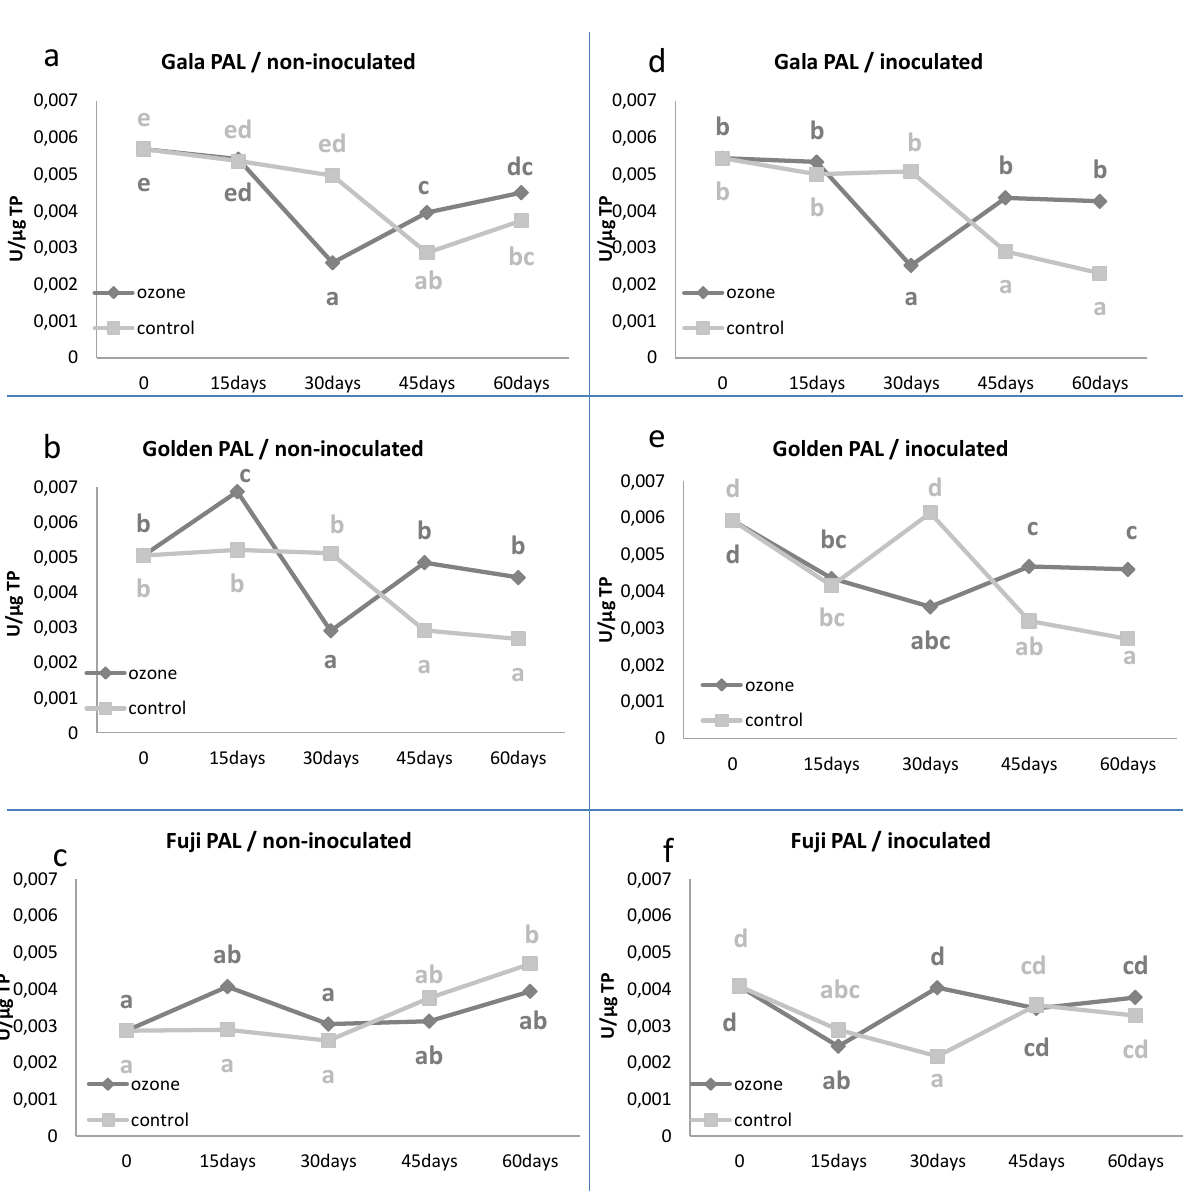
Figure 5. Mean phenylalanine ammonia-lyase specific activity in non-inoculated and Penicillium expansum inoculated ap- ple fruits (‘Royal Gala’, ‘Golden Delicious’, ‘Fuji’), either non-treated (a, b, c) (control) or treated by ozone at 0.5 μL L -1 (c, d, e), stored at 1°C±1 in the dark. Means followed by the same letter are not significantly different (Fisher’s Least Significance Difference test (LSD, P =